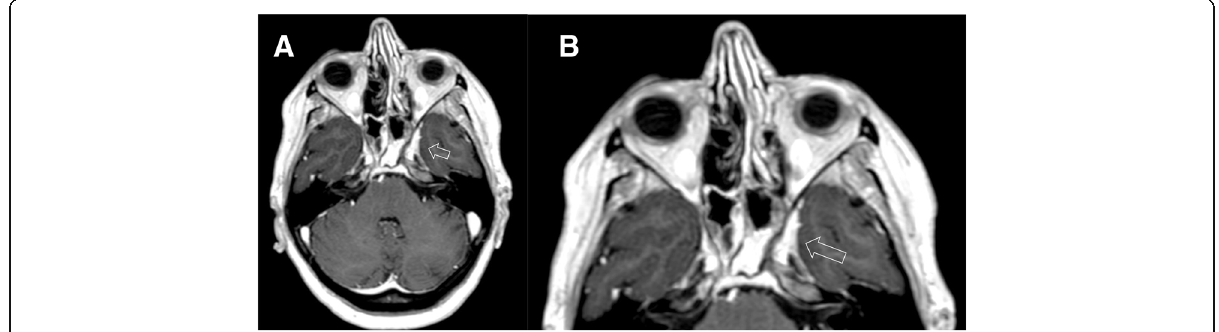
Fig. 25 Tolosa-Hunt syndrome. MRI T1-weighted post-gadolinium axial image ( a , and enlargement in b ) shows enhancing inflammatory infiltration in the left orbital apex extending into the cavernous sinus (empty arrows)